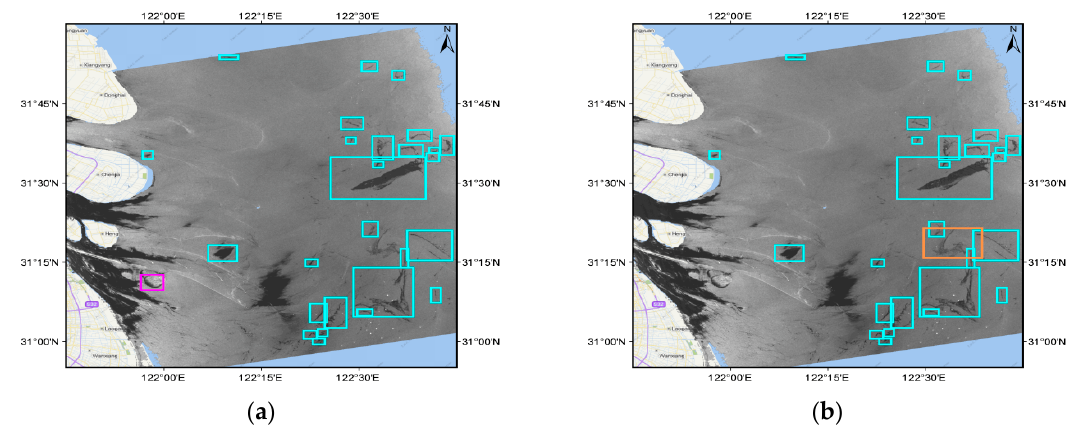
Figure 12. Typical SAR image containing oil spills: ( a ) Oil spills classified by AAMLP. The dark patch marked with a magenta box is a false alarm due to shoal; ( b ) oil spills classified by OSCNet. The false alarm of (a) has disappeared and the dark patch marked with an orange box is missed by AAMLP, but correctly classified by OSCNet. Table 11. The dark patches misclassified by AAMLP, but correctly classified by OSCNet.